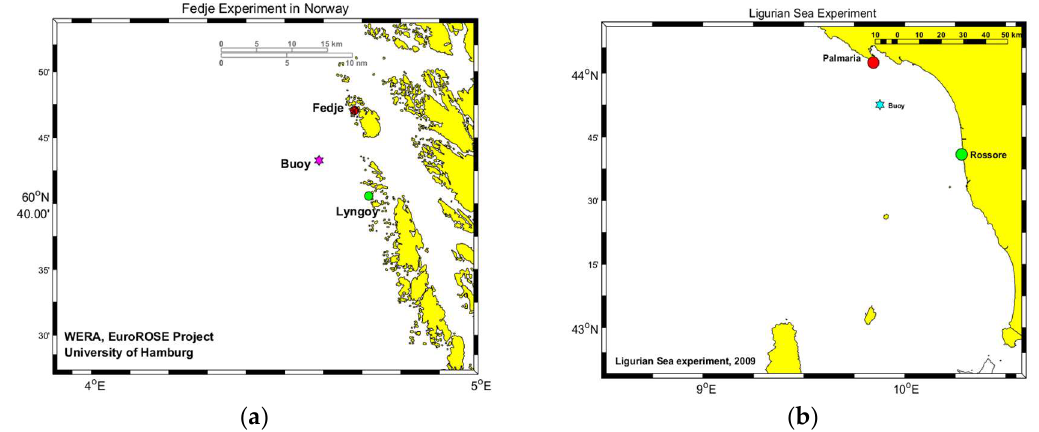
Figure 6. The deployments of radar sites and in situ buoys: ( a ) the Fedje experiment in Norway; ( b ) the Ligurian Sea experiment in Italy.